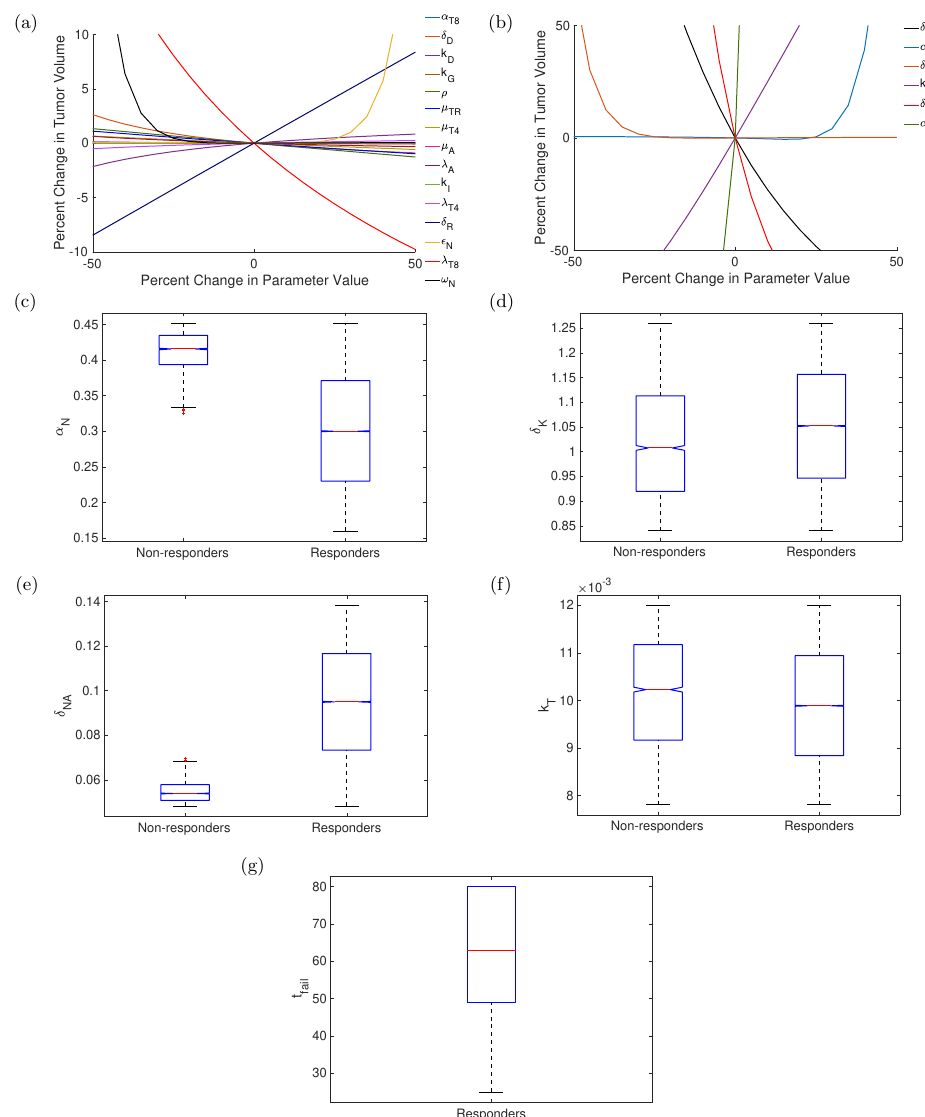
Figure 8. Local sensitivity and uncertainty analyses on fitted model parameters. ( a , b ) Results of a local sensitivity analysis to identify model parameters that are critical determinants of response to ADT in combination with Provenge. ( c – f ) Median and inter-quartile range of parameters that were found to be significantly associated with a positive response to combination therapy, as determined by > 0 times to treatment failure. ( g ) Predicted median and inter-quartile range of time to treatment failure in the Responder